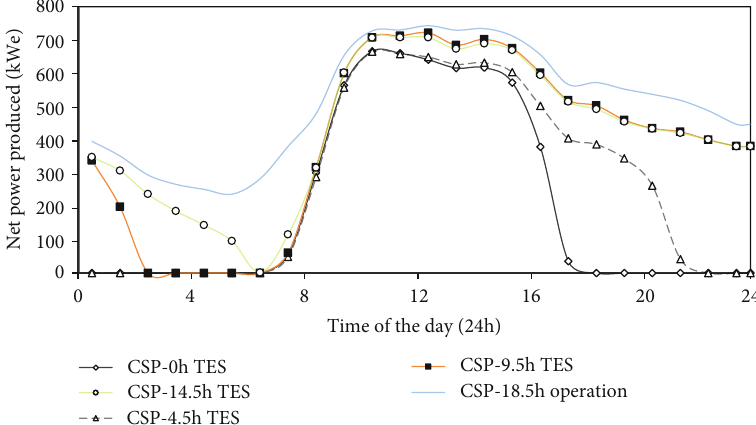
Figure 17: Typical annual net power output pro fi le of 1MW PT-CSP